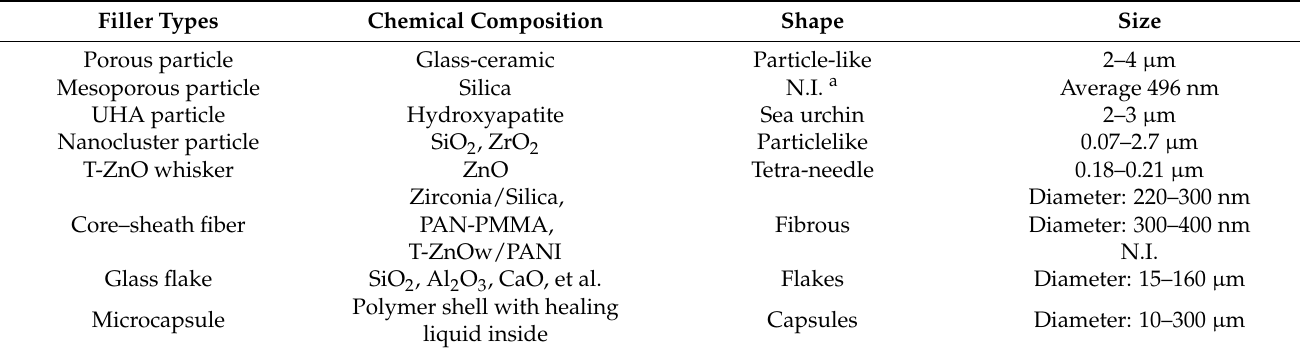
Table 3. Types of novel-shaped fillers by morphology modification.